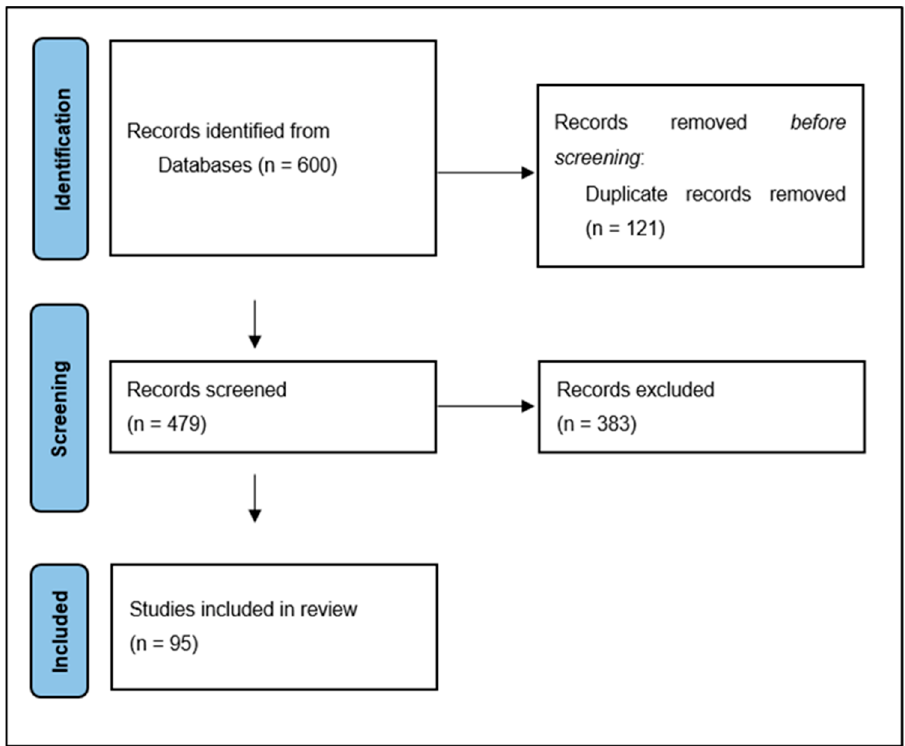
Figure 1. Flow diagram of the search strategy.